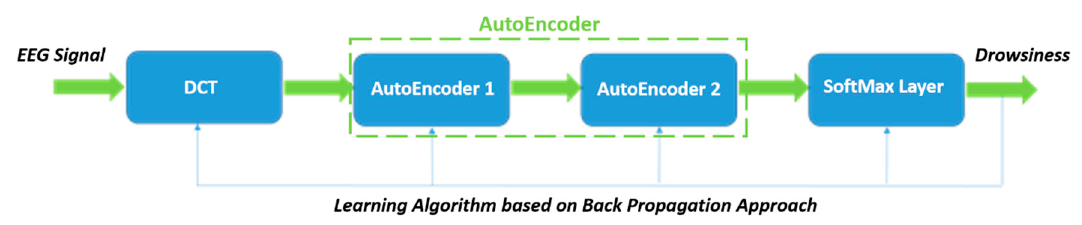
Figure 1. The proposed Deep Neural Networks-based pipeline.